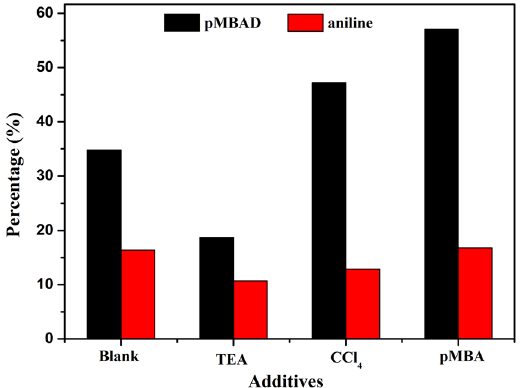
Figure 14. The yield of p-methoxybenzaldehyde (p-MBAD) and aniline over CdIn 2 S 4 by adding different additives under visible light for 4 h.